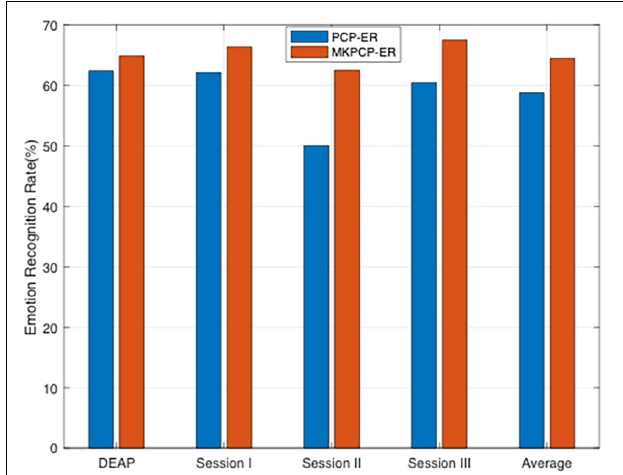
FIGURE 2 | PCP-ER with multi-kernel learning.